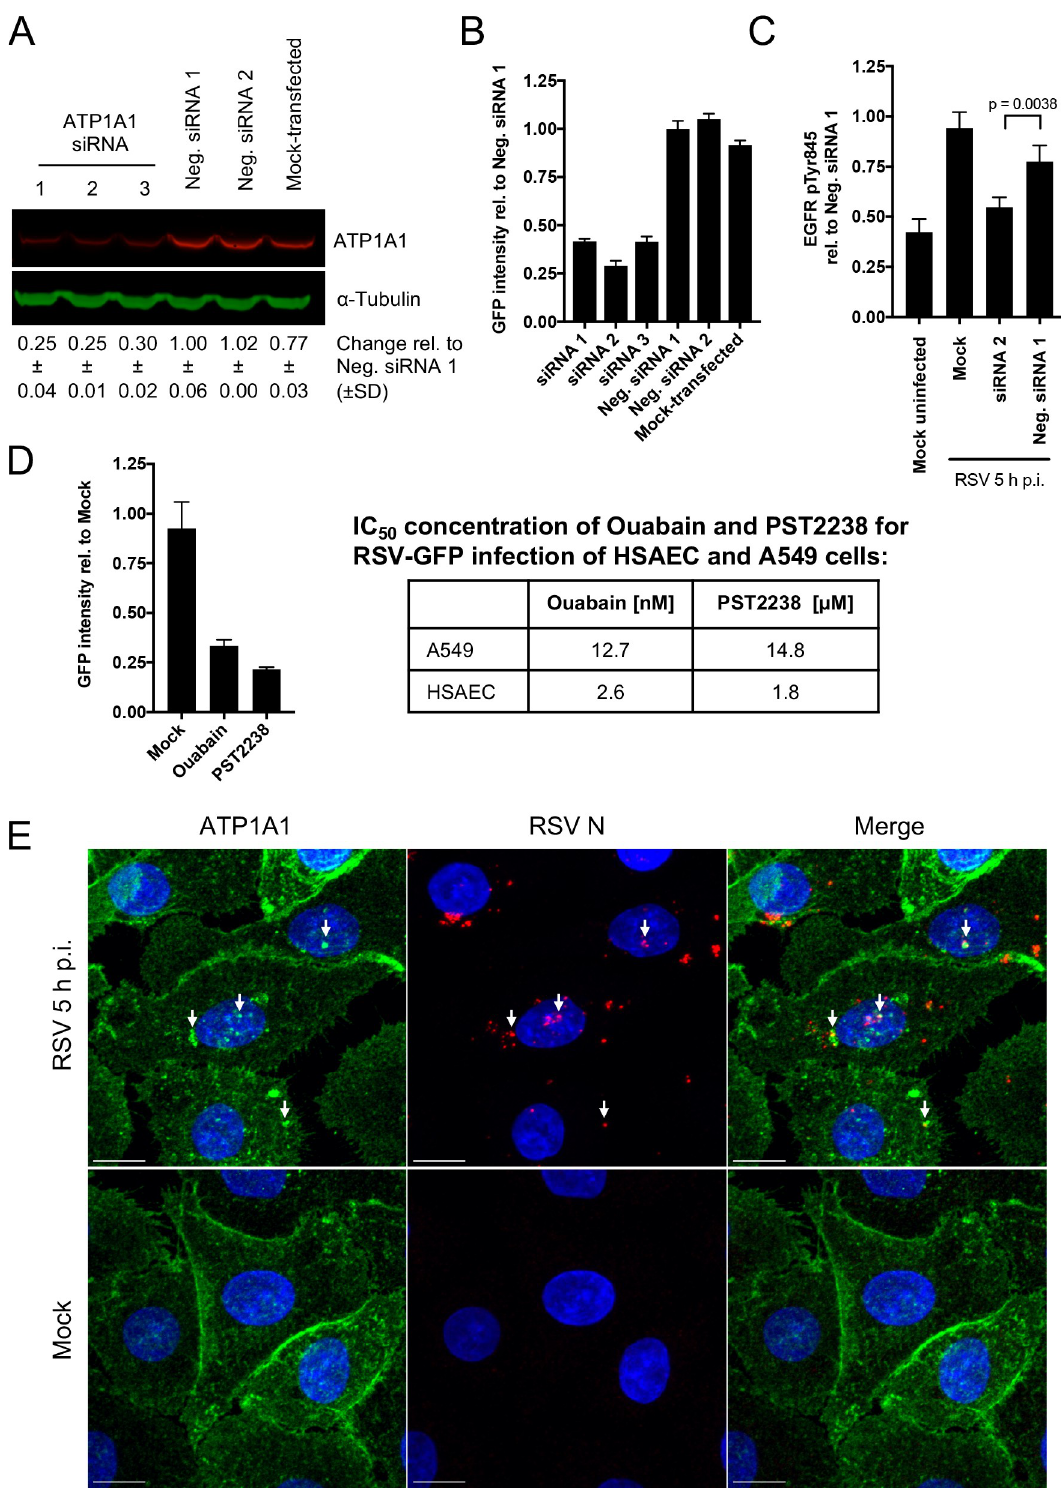
Fig 11. Confirmation of results obtained in the A549 cell line by experiments in primary human small airway epithelial cells (HSAEC). Experiments were performed as described for A549 cells in the Materials and Methods section and the preceding Figure legends. (A) siRNA knockdown in HSAEC using ATP1A1 siRNAs 1, 2, and 3 and Neg. siRNAs 1 and 2, analyzed 48 h p.t., by Western blot analysis as in Fig 1B. (B) Efficiency of RSV infection in HSAEC cells following knockdown of ATP1A1 expression